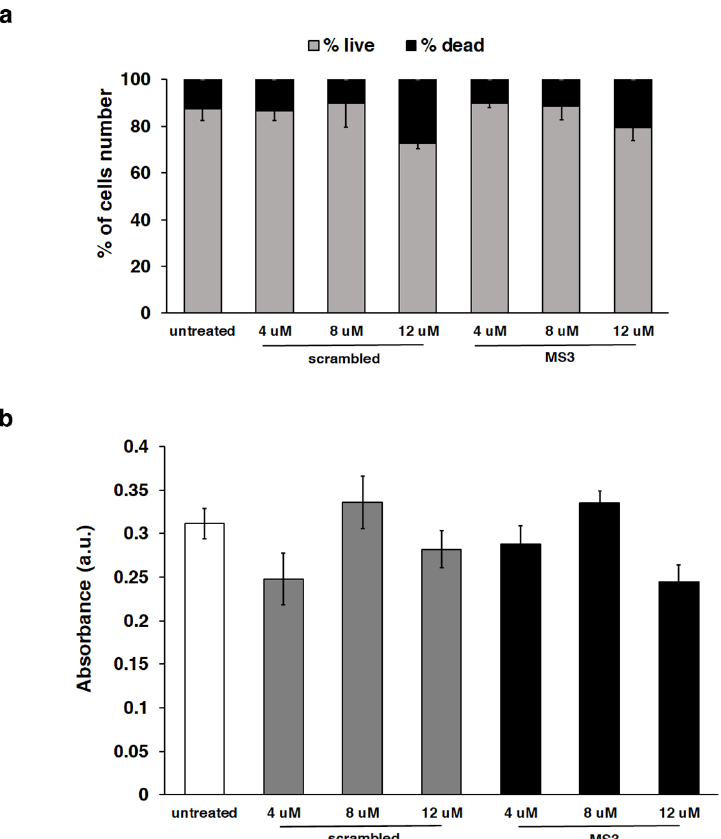
Figure 5. Evaluation of cell viability and metabolic activity of SH-SY5Y cells after treatment with the scrambled oligonucleotide or MS3 aptamer in comparison with untreated cells. ( a ) Percentage of viable and dead cells after trypan blue staining. ( b ) MTT assay results. For both assays, the reported values represent the mean of biological triplicate of two independent experiments; error bars, mean ± SD. No statistical significance, Student t -test.